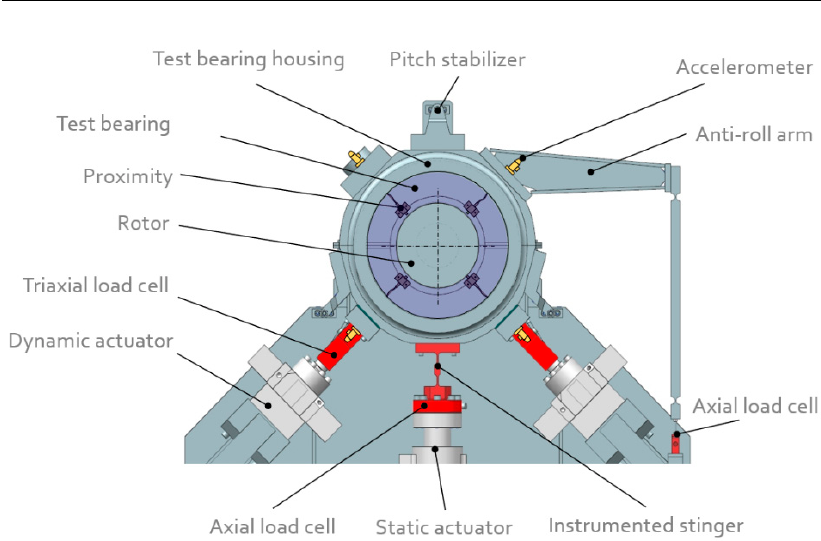
Figure 3. Section of the test apparatus on a plane orthogonal to the bearing